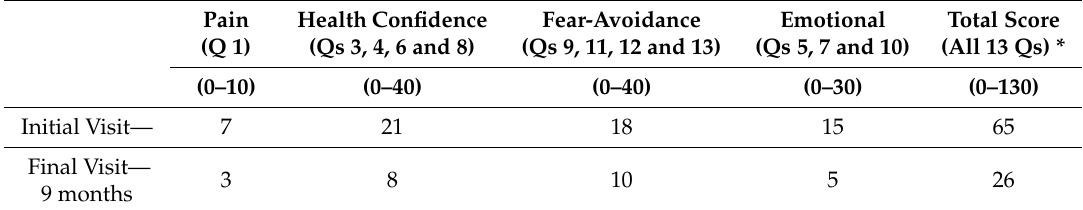
Table 1. Pre-intervention and post-intervention Yellow Flags Questionnaire (YFQ)